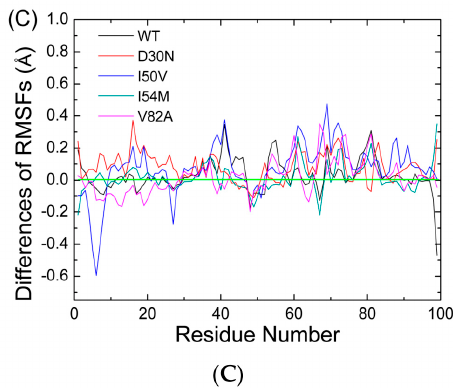
Figure 2. ( A ) The root mean square deviations (RMSDs) of the backbone atoms relative to their crystal structures as a function of MD simulation time; ( B )the root mean square fluctuations (RMSFs) of backbone atoms versus residue number; ( C ) the differences of RMSFs values of the same residues in two chains versus residue number.